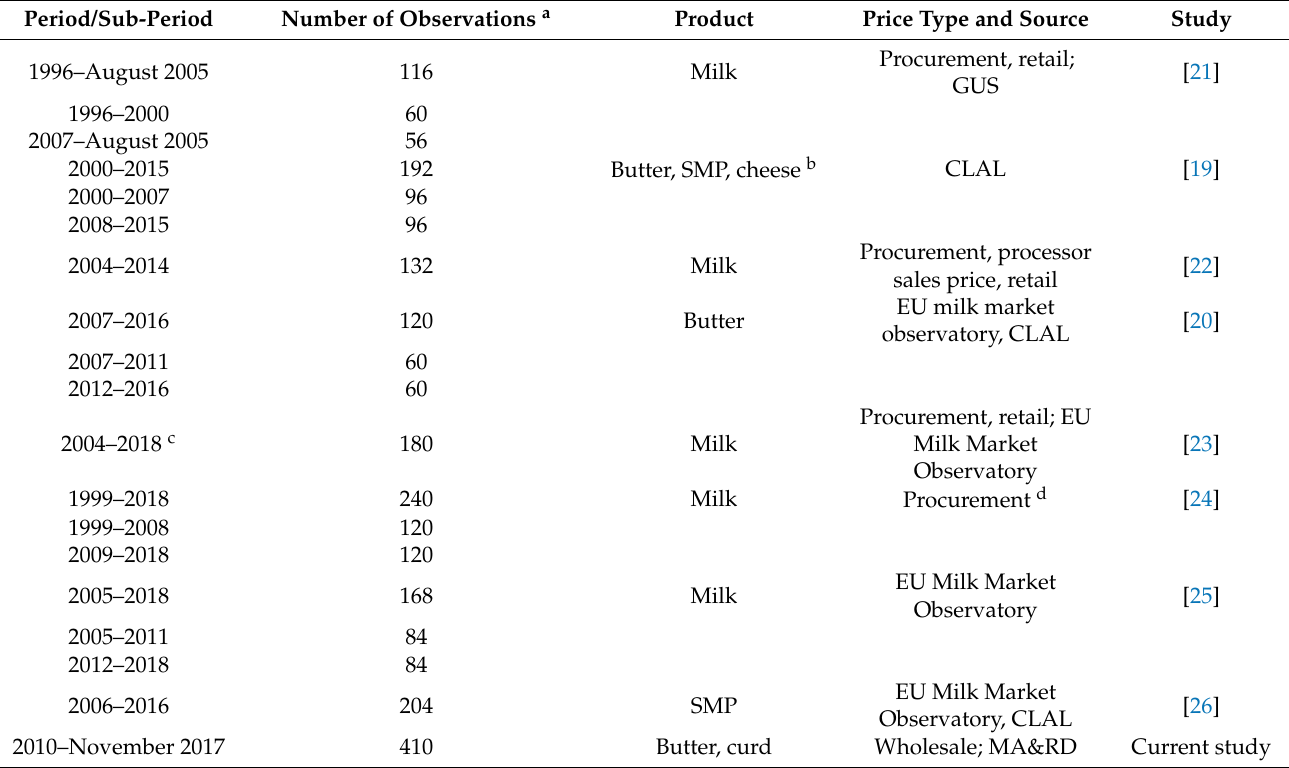
Table 1. Number of monthly observations in the studies of selected dairy